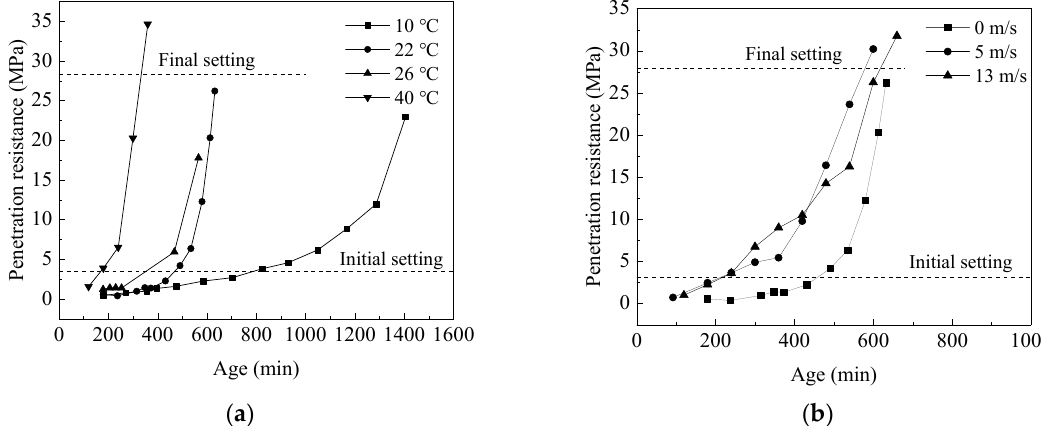
Figure 4. The change of penetration resistance of mortar under different environmental factors: ( a ) temperatures of 10, 22, 26 and 40 °C, non-windy, ( b ) 22 °C, wind speeds of 0, 5 and 13 m/s.